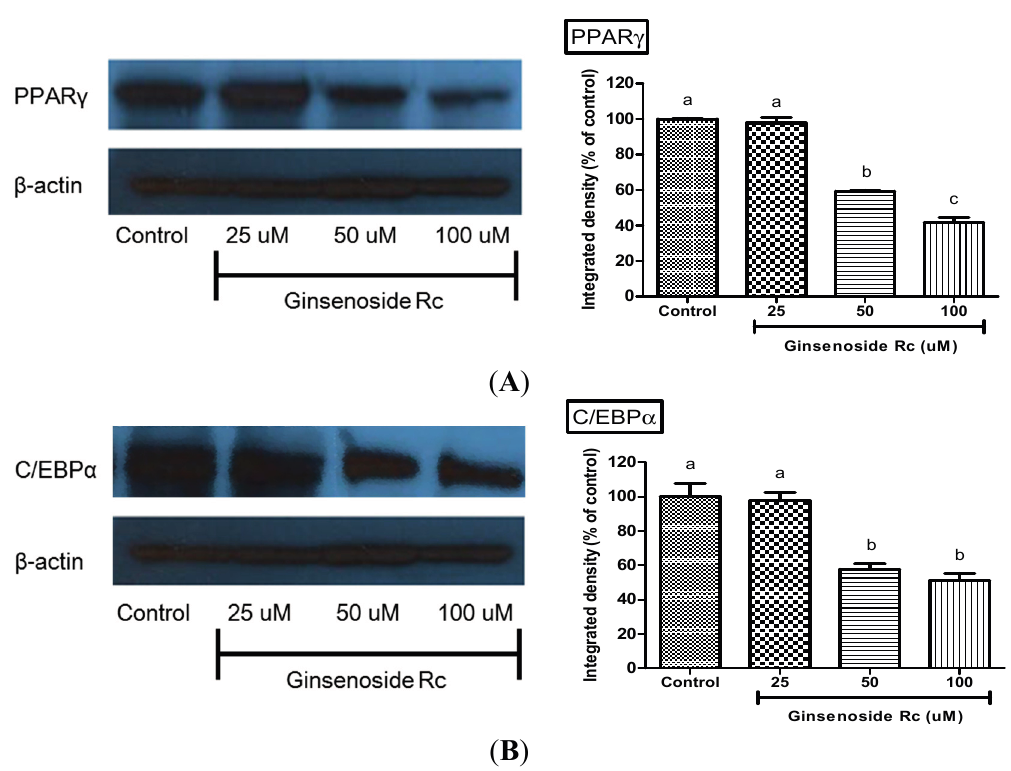
Figure 3. Effect of ginsenoside Rc on protein expression of ( A ) PPAR γ ; and ( B ) C/EBP α in 3T3-L1 cells. 3T3-L1 adipocytes were harvested 9 days after the initiation of differentiation. Expression was analysed by western blotting using specific antibodies. Data are presented as the mean ± standard errorof triplicate experiments. a–c significant difference in treatment concentrating to ANOVA followed by Duncan ( p <